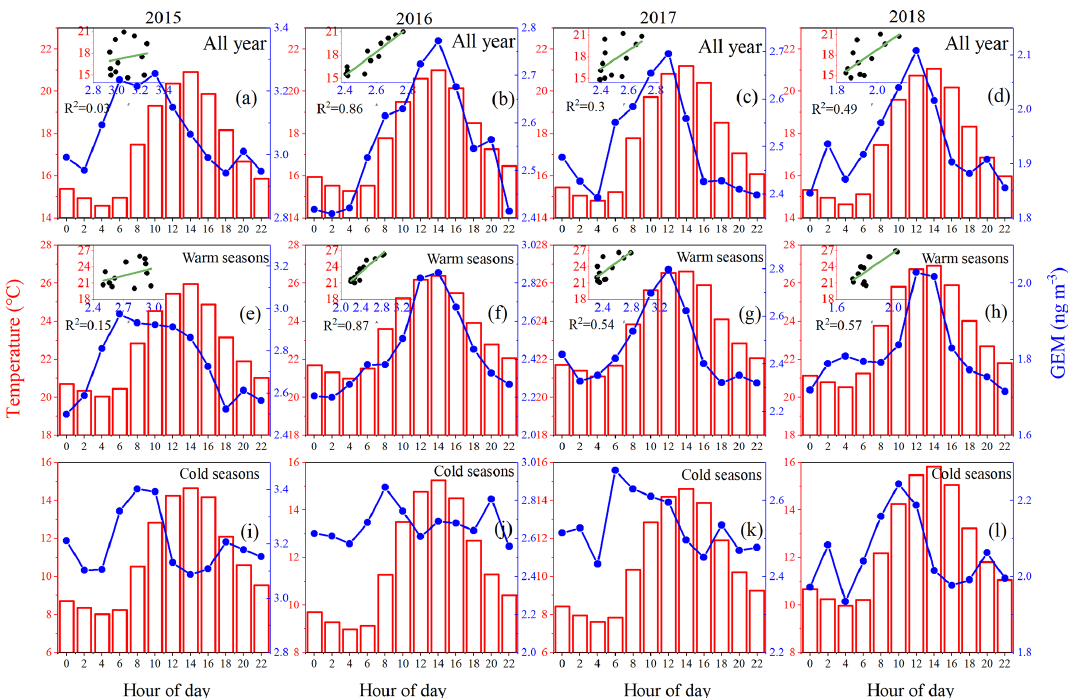
Figure 4. Diurnal patterns of bi-hourly GEM concentrations and temperature for the (a–d) whole year, (e–h) warm seasons, and (i–l) cold seasons during 2015–2018. The linear correlations between GEM and temperature are inserted as